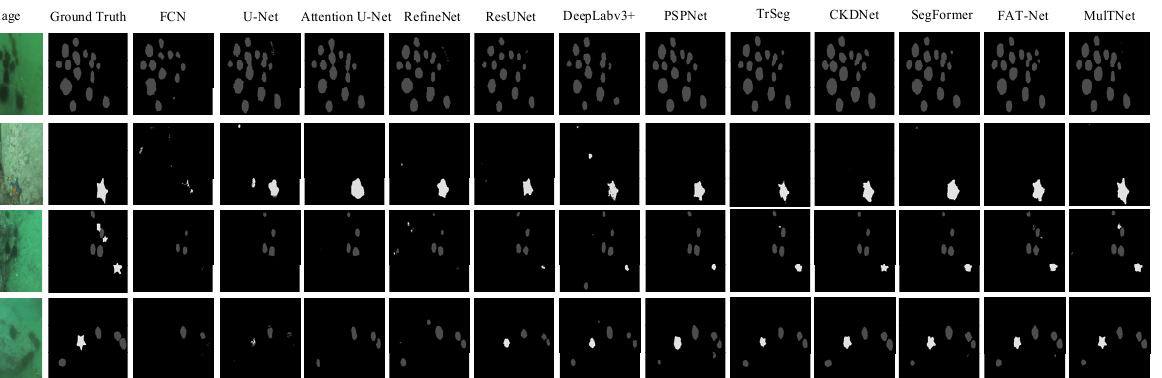
Figure 2. E xamples of the marine animal segmentation obtained by FCN-8s, U-Net, Attention U- Net, RefineNet, ResUNet, Deeplabv3+, PSPNet, TrSeg, CKDNet, SegFormer, FAT-Net, and the pro- posed MulTNet.